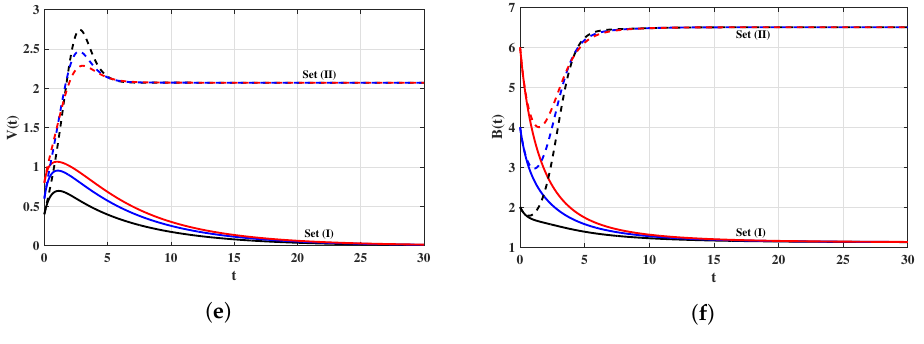
Figure 1. The simulation of trajectories of the system in Equations (9)–(12) with IV1–IV3; ( a ) uninfected target cells type-1; ( b ) uninfected target cells type-2; ( c ) infected target cells type-1; ( d ) infected target cells type-2; ( e ) free virus particles; and ( f ) B cells.